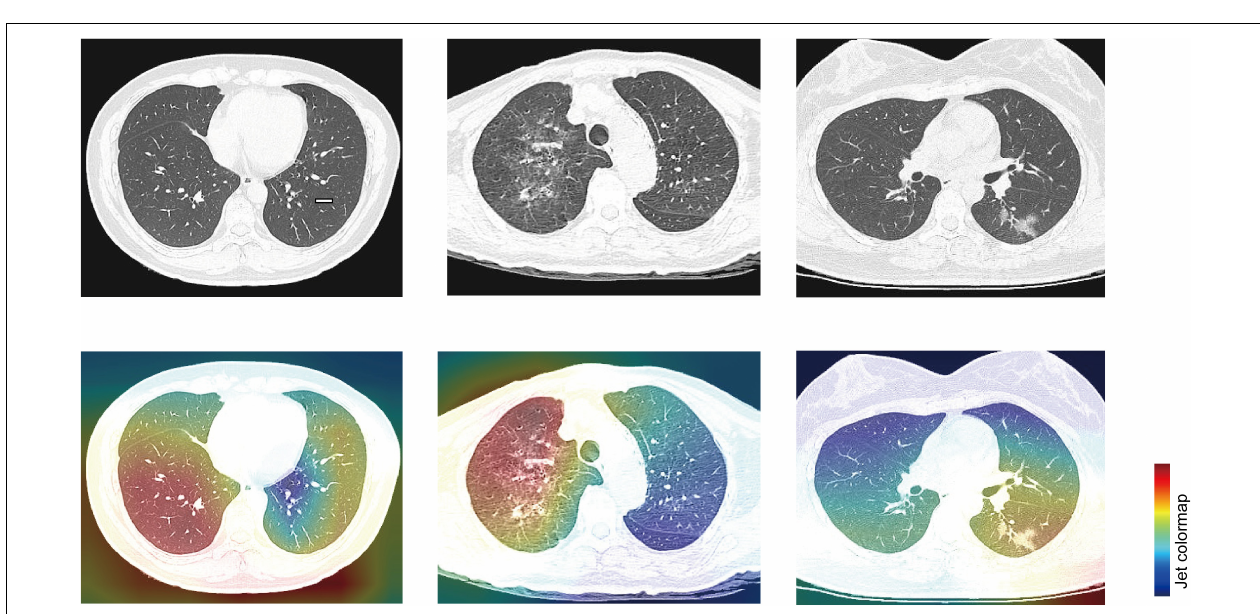
FIGURE 2 | Performance of our AI systems in differentiating COVID-19 from other common pneumonia and normal controls. (A) ROC curves of vgg16, vgg19 and resnet18 systems. (B) Normalized confusion matrix of vgg19 system.